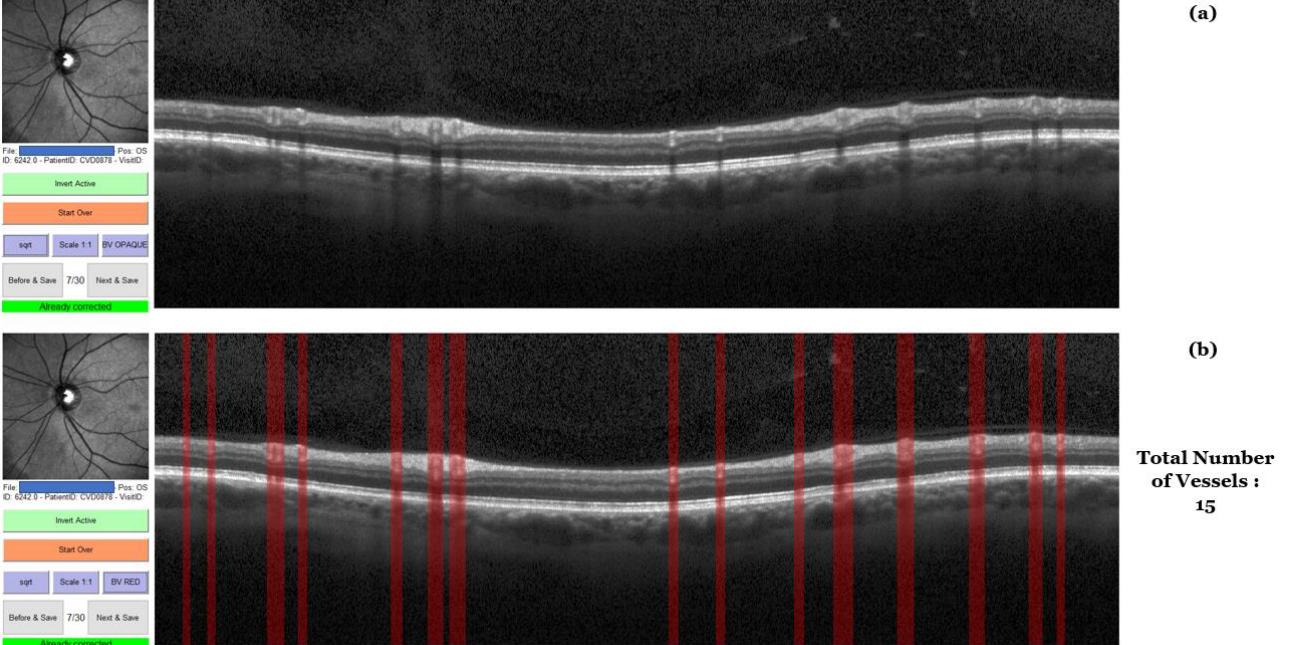
Figure 2. An example of manual OCT segmentation in the OCTSEG software. ( a ) An OCT image imported into the OCTSEG software with no segmentation. ( b ) A figure of the OCT shown in ( a ) but after manual segmentation. The segmentations are represented as red columns spanning the diameter of the blood vessel. Our code returns a total of 15 blood vessels in this example.